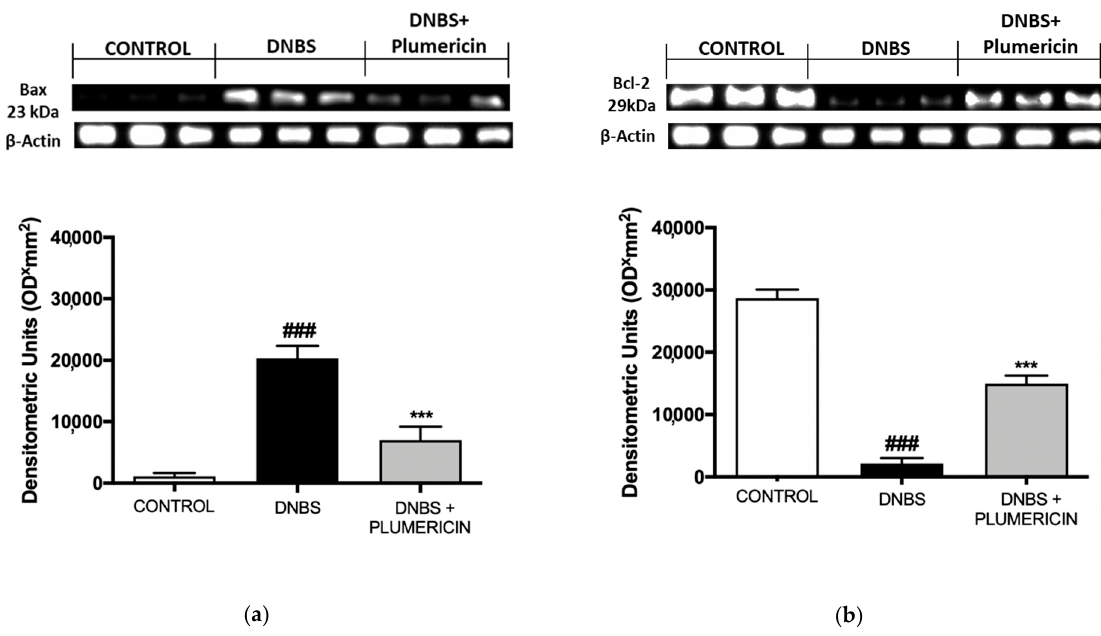
Figure 8. Bax ( a ) and Bcl-2 ( b ) expression was measured by Western blot. Densitometric analysis of protein bands was normalized to the level of β -actin. Data are representative of at least three independent experiments and are expressed as mean ± S.E.M. from 10 animals for each experimental group. A representative blot is shown and densitometric analysis is reported. ### denotes p < 0.001 vs. control; *** denotes p < 0.001 vs. DNBS.